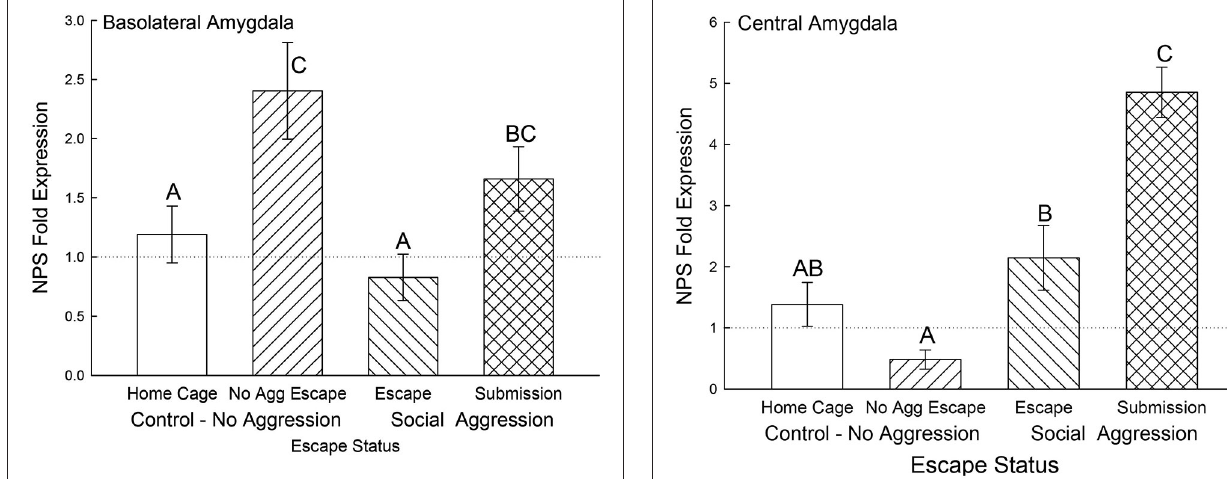
FIGURE 8 | Expectation of social aggression elevates central amygdala NPS expression . Mean ( ± SEM) fold expression of NPS mRNA in CeA on test day (CS+, US − ) after SAM social interaction for cage control (clear bars; N = 11), after SAM exposure in mice not receiving aggression (bars with left hatch; N = 6), after SAM plus social interaction in mice escaping aggression (right hatch; N = 7) and submissive mice (cross hatch; N = 4). Letters above the bar (A, B, C) signify statistical significance ( p < 0.05), such that bars that do not share a common letter (e.g., Escape = B vs. Submission = C) are significantly different, and those that do share a letter (e.g., Home Cage = AB vs. No Aggression Escape = A) are